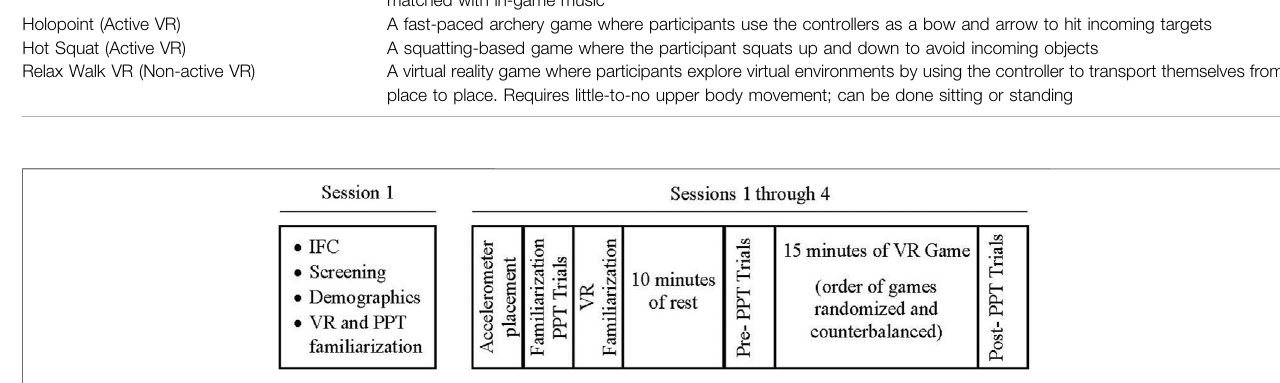
TABLE 1 | Virtual reality games descriptions. Game Description Beat Saber (Active